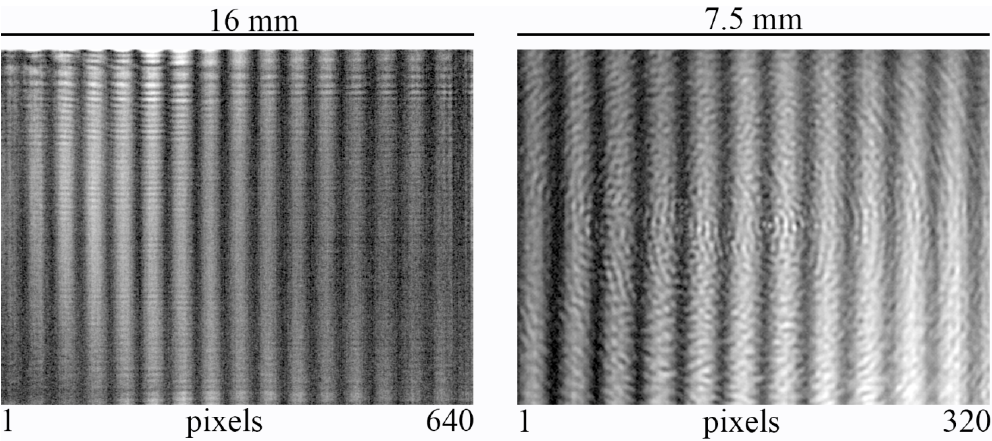
Figure 4. Relative camera response across the entire image area at λ = 118.8 μ m ( a – d ). A value of one corresponds to the average response of the image area. ( a ) Cam1; ( b ) Cam2; ( c ) Cam3; ( d ) Cam4; ( e ) Cam1 at λ = 96.5 μ m.